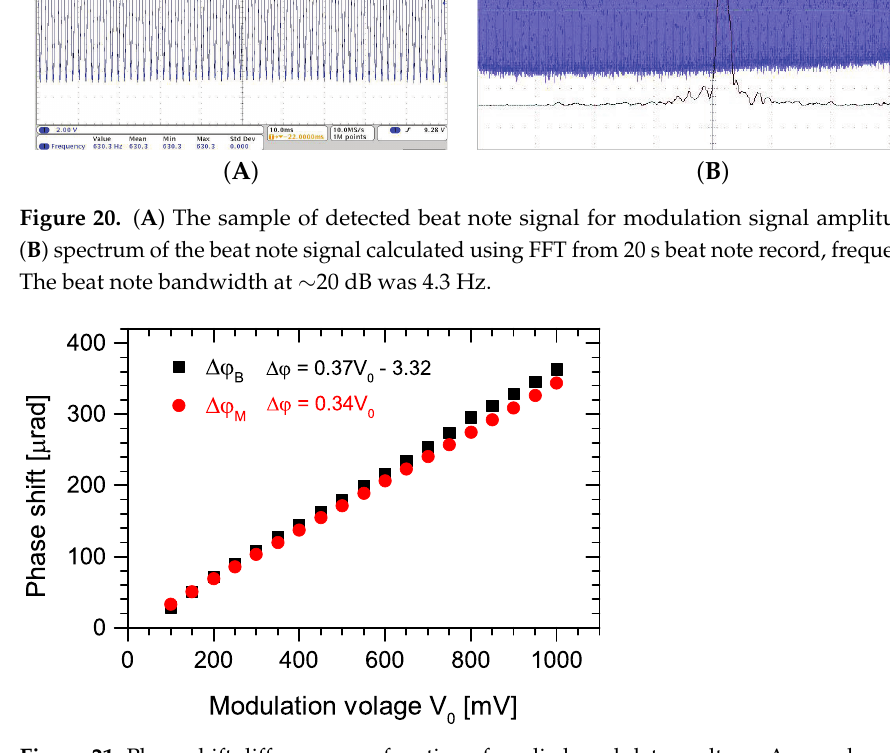
Figure 21. Phase shift difference as a function of applied modulator voltage: ∆ ϕ B —phase shift differ- ence calculated from the measured beat note frequency for given modulator voltage, ∆ ϕ M —phase shift difference calculated from applied voltage and material parameters of lithium